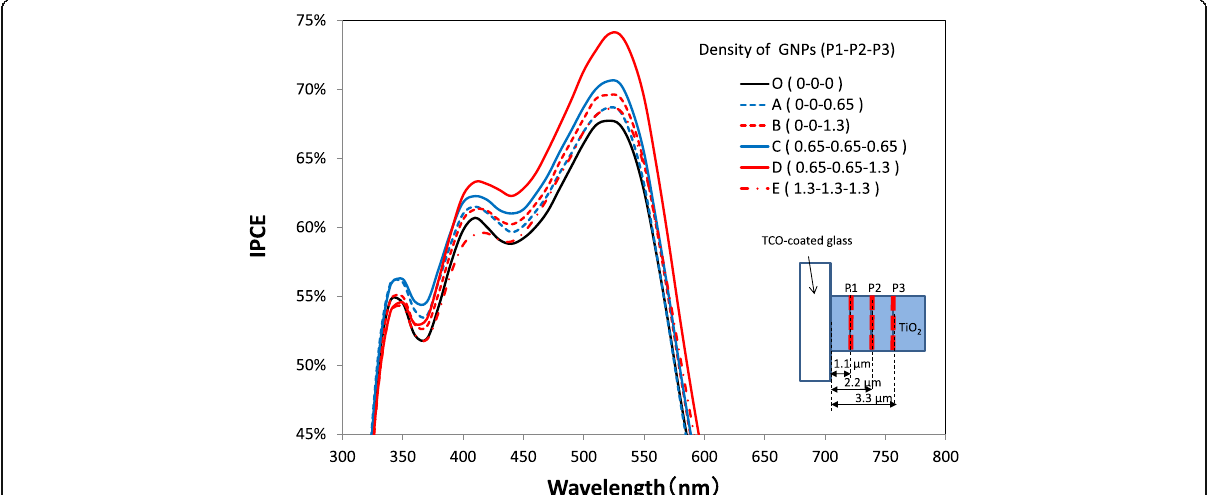
Fig. 15 IPCE spectra of the DSSCs with varying the layer number and the density of GNPs. The GNP layers of P1, P2, and P3 were formed at positions of 1.1, 2.2, and 3.3 μ m from the TCO surface, respectively. The numbering in the legend with the format (P1-P2-P3) shows the density of GNPs ( μ g/cm 2 ) at each